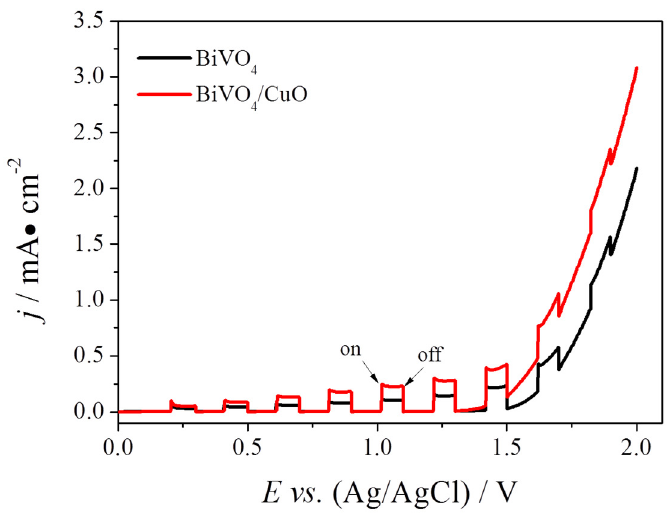
Figure 3. Linear sweep voltammograms of BiVO 4 and BiVO 4 / CuO. Experiments performed in 0.1 mol ∙ L − 1 Na 2 SO 4 at scan rate of 50 mV ∙ s − 1 .